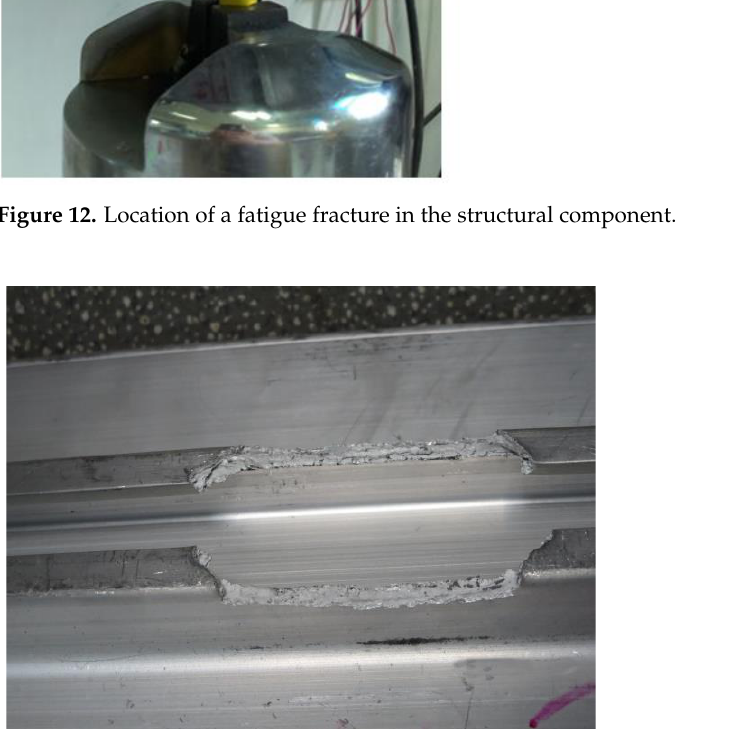
Figure 14. Fatigue life data and load – life curve of structure component. Using Equation (2), we can obtain that when the load level is 11kN, the correspond- ing fatigue life is 1823055 cycles. For the design analysis of suspension structural members, load – life curves based on different confidence levels and different reliability levels (probabilistic life curves, P-S-N